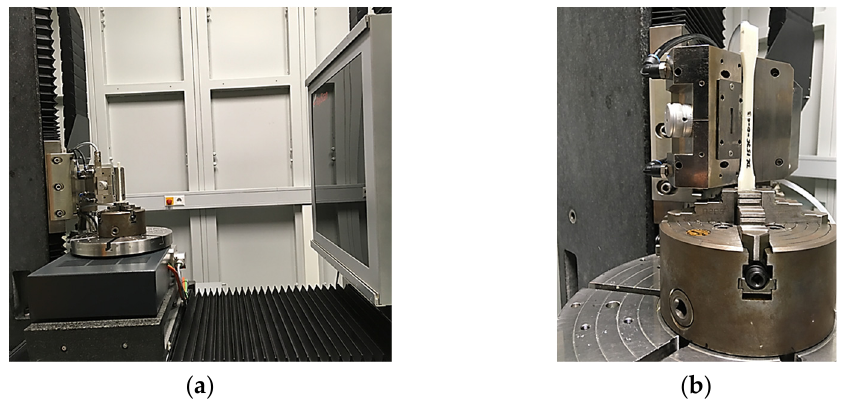
Figure 4. Experimental set up used for fiber orientation analysis of the PP/GF30 short fiber-reinforced thermoplastic composite: ( a ) computed tomography system and ( b ) test specimen clamped on turntable.